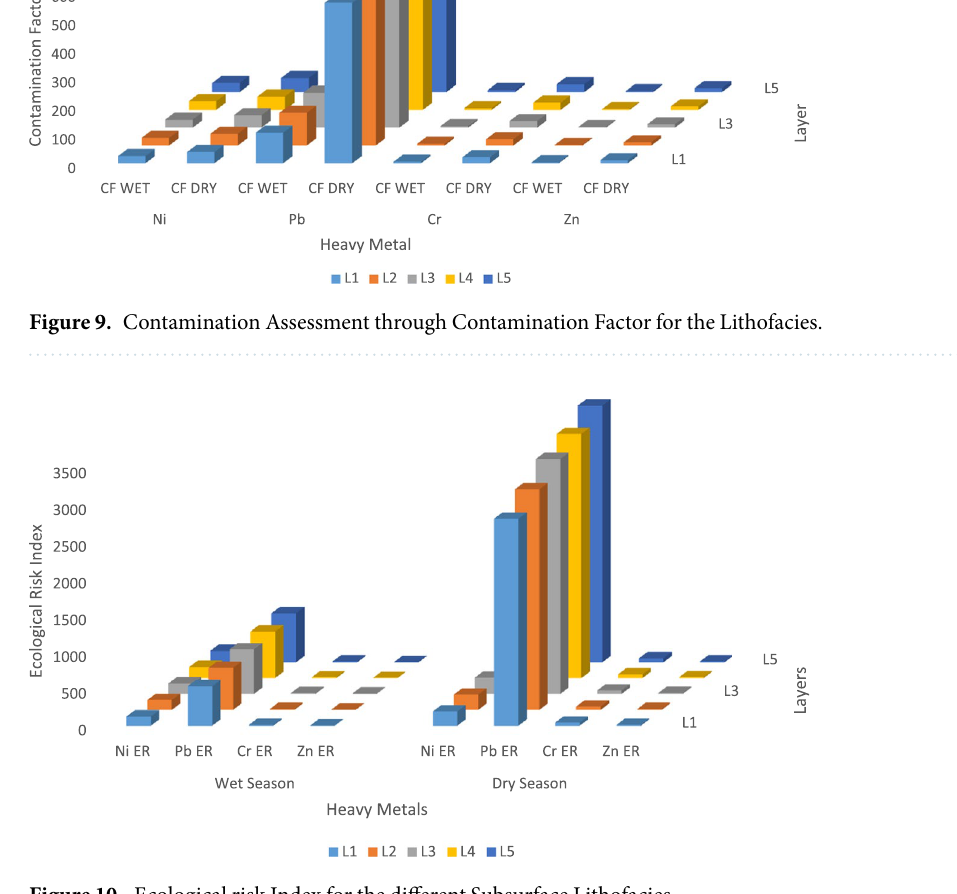
Figure 10. Ecological risk Index for the different Subsurface Lithofacies.